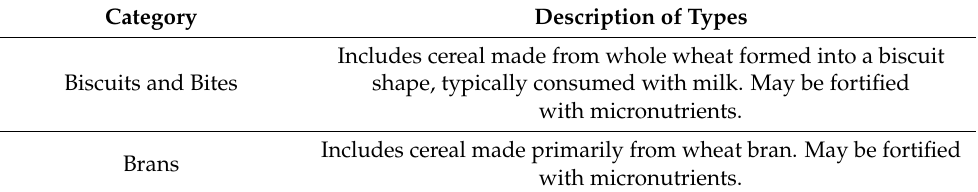
Table 1. Classification of Breakfast Cereal